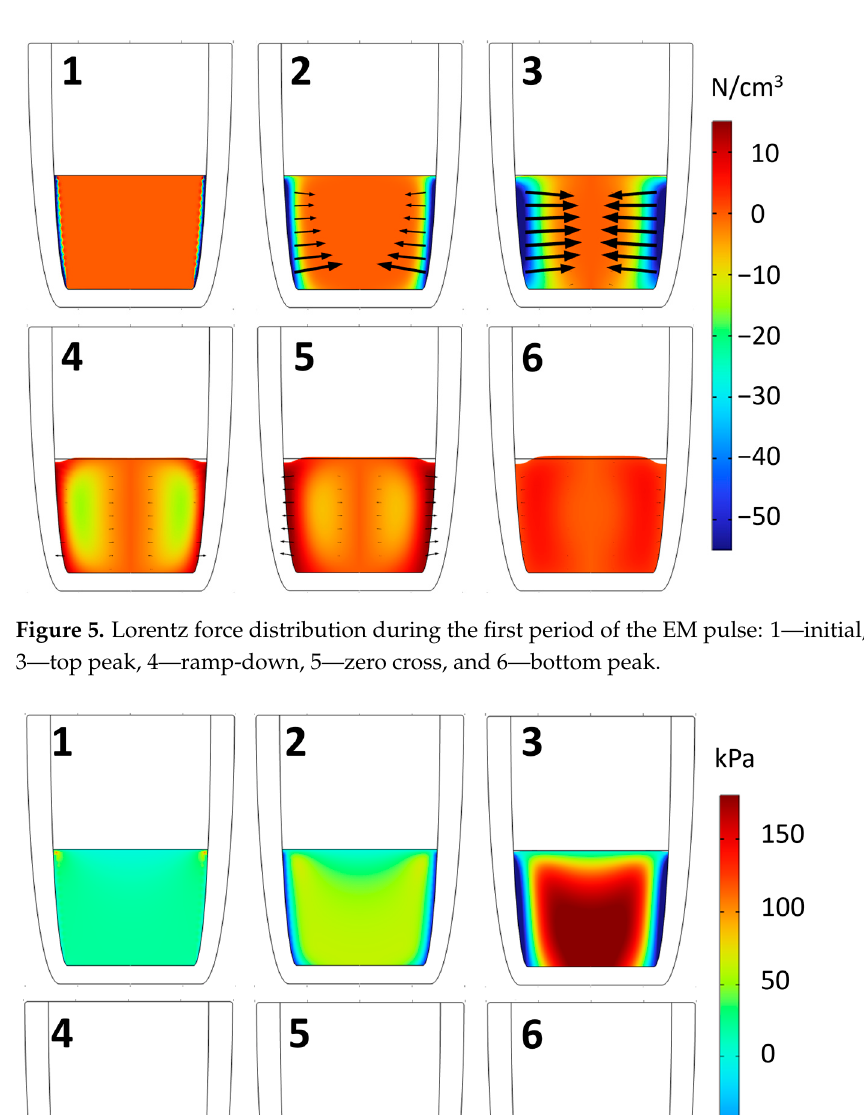
Figure 6. Pressure distribution during the first period of the EM pulse: 1—initial, 2—ramp-up, 3—top peak, 4—ramp-down, 5—zero cross, and 6—bottom peak.